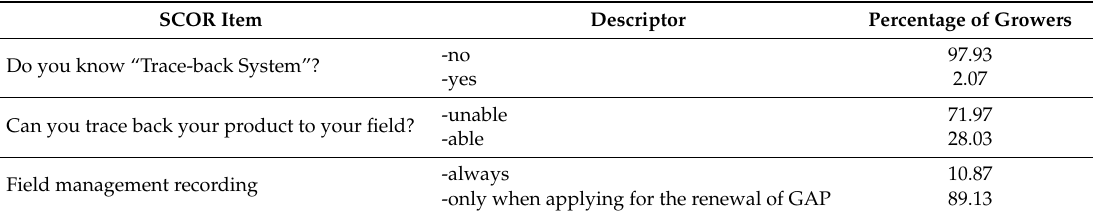
Table 6. Traceability management in mango orchards.